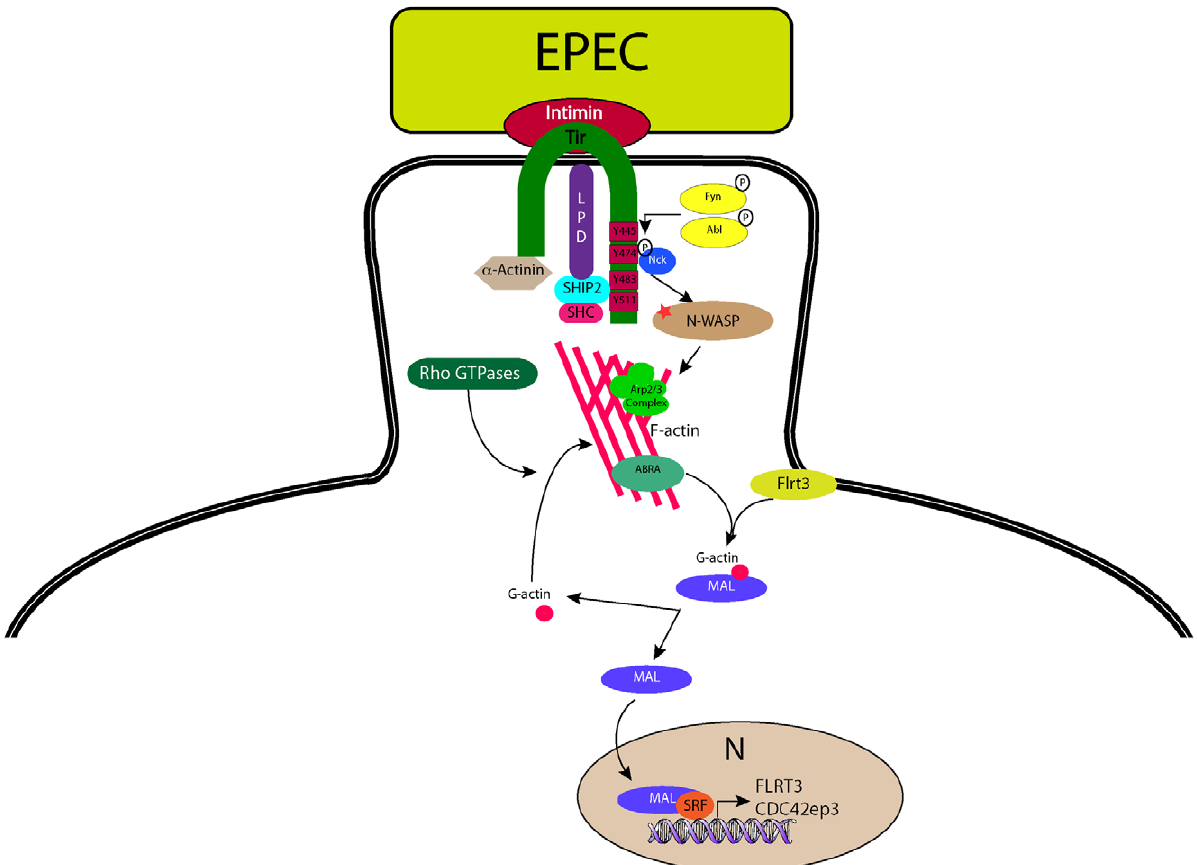
Figure 8. A model for EPEC-induced activation of host-cell transcription factor SRF. During infection with the extracellular pathogen EPEC, Tir translocates to the host cell and inserts into the plasma membrane where it interacts with the bacterial surface protein intimin and anchors it to the cell. The C-terminus of Tir is phosphorylated by host cell kinases leading to the recruitment and binding of Nck. N-WASP and the Arp2/3 complex are recruited leading to the generation of actin filaments beneath the bacterium. ABRA can bind actin in the newly formed (or forming) pedestal and stabilise the structure. The change in G-actin to F-actin ratio induced by pedestal formation is ‘‘sensed’’ by MAL via direct or indirect actions from ABRA and FLRT3, whereupon it is freed from its inhibitory complex with G-actin, to enter the nucleus and interact with SRF, driving transcription of target genes.